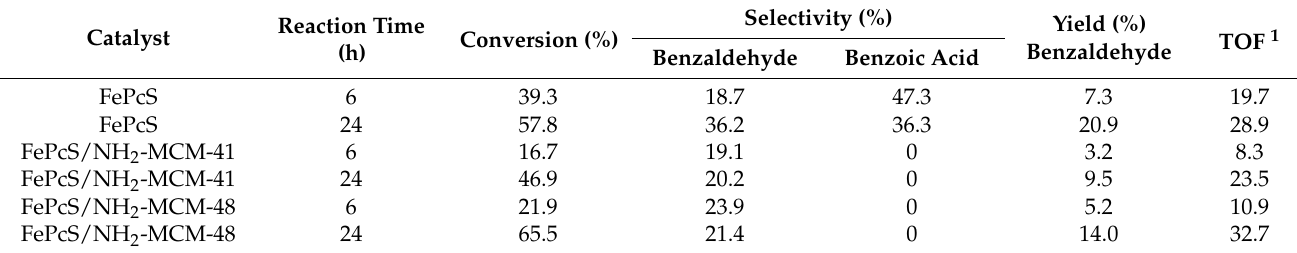
Table 2. Oxidation of styrene in homogeneous and heterogeneous systems with FePcS [55].